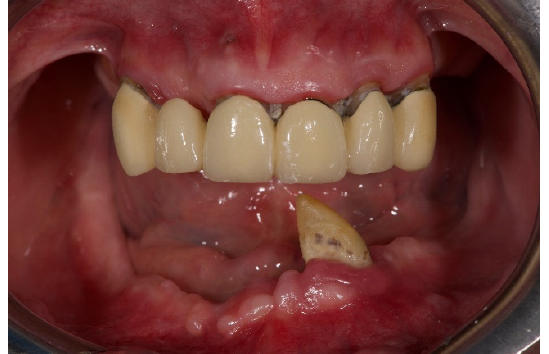
Figure 1. Preoperative frontal view.